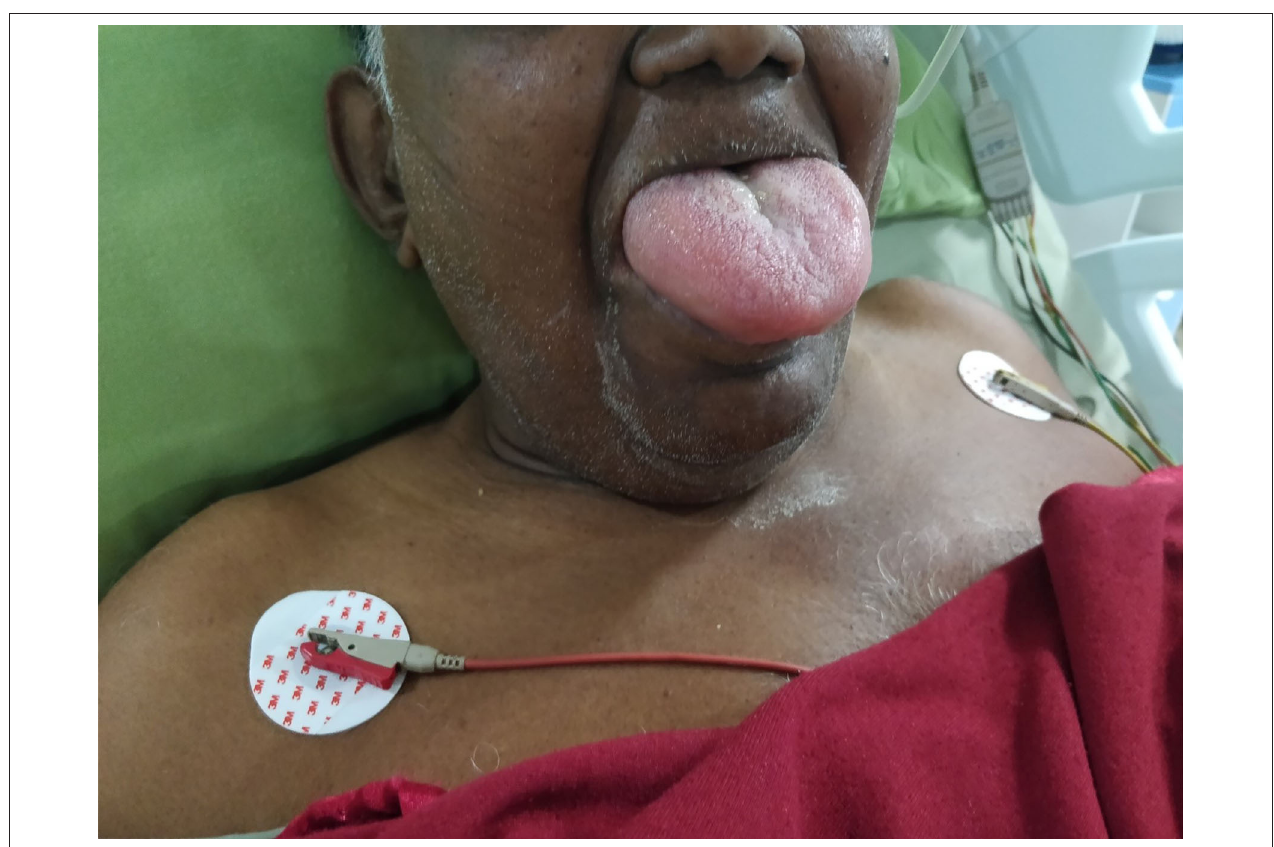
FIGURE 1 | Post-operative massive tongue